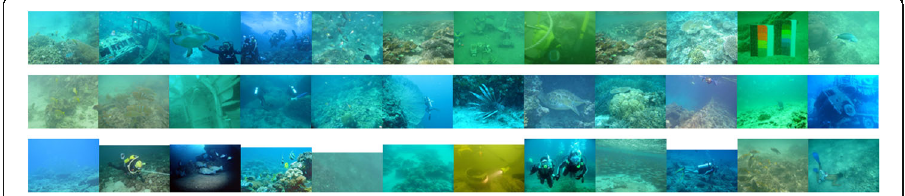
color with better contrast between objects, which produced the highest scores of UCIQE = 0.6761 and UIQM = 4.1770.